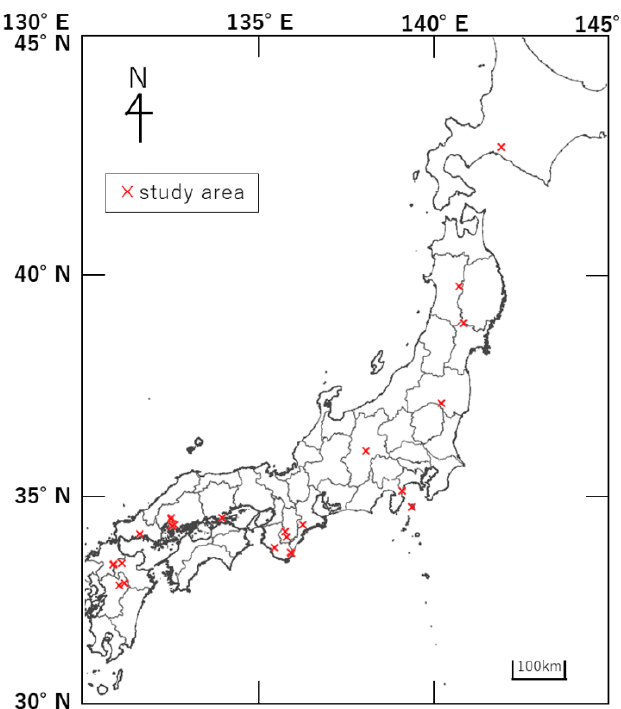
Figure 1. Location of study areas. (Partially edited from